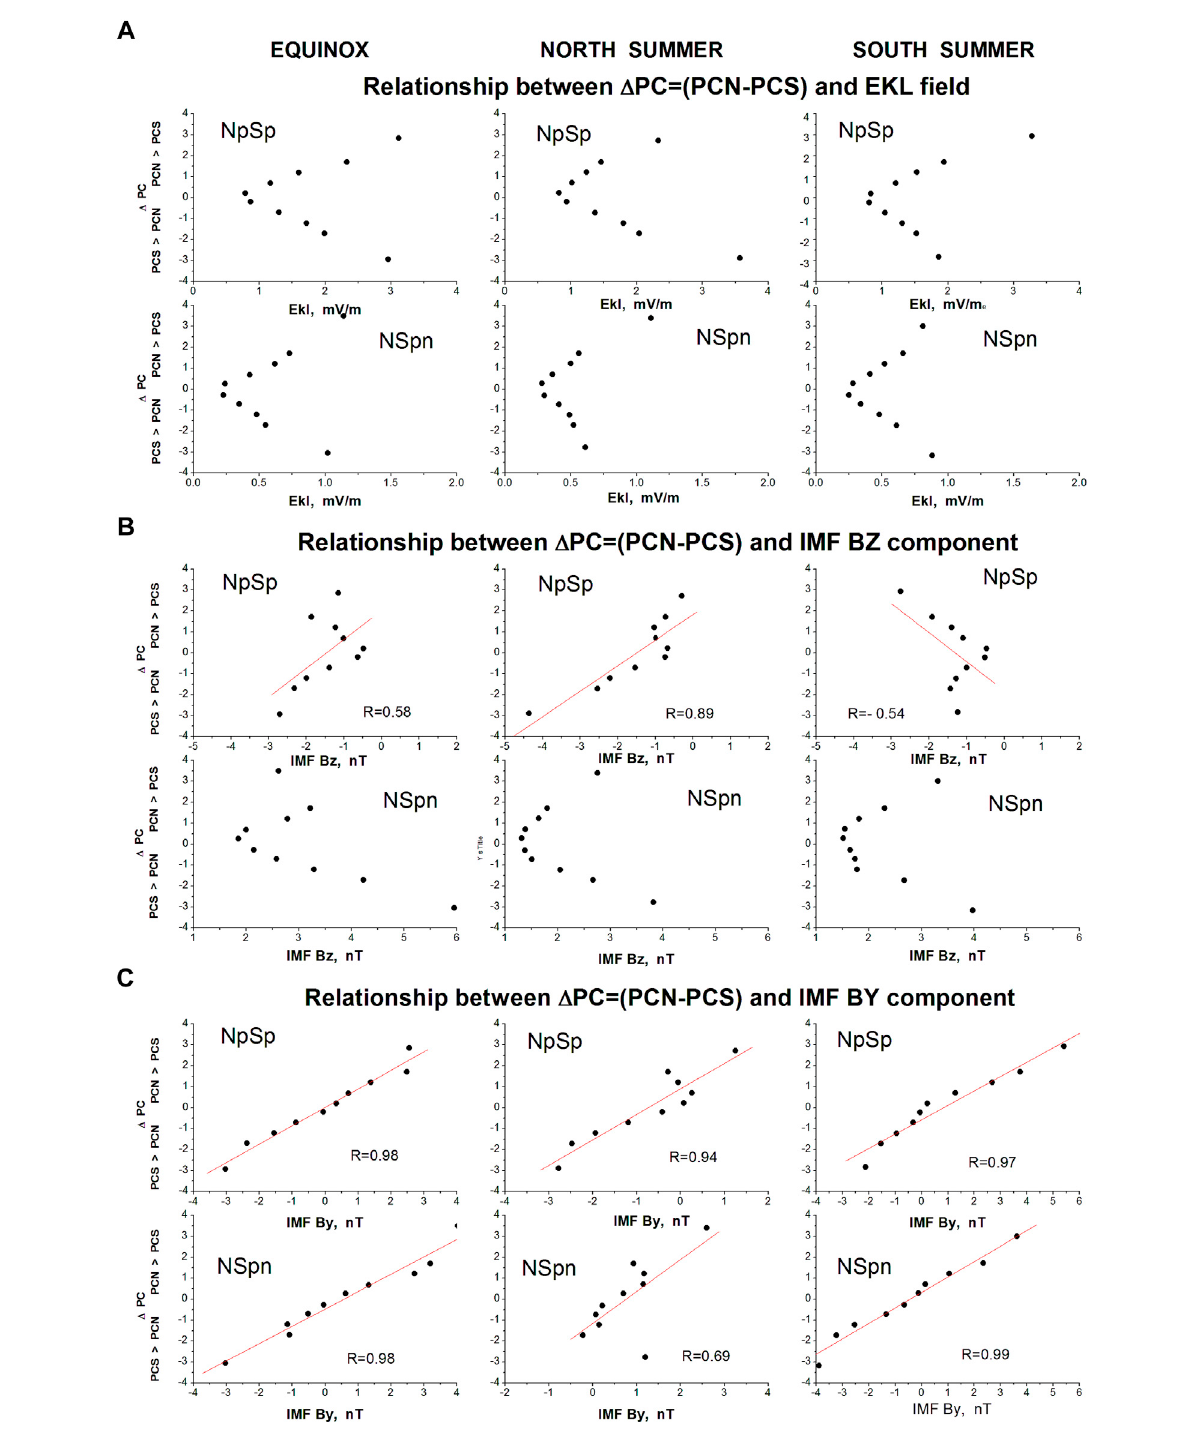
FIGURE 15 Relationships between the mean hourly values of Δ PC and E KL fi eld (A) , IMF BZ component (B) , IMF BY component (C) in equinox (left column), north summer (middle), south summer (right) for positive (NpSp), and contrary (NSpn) signs of PCN and PCS